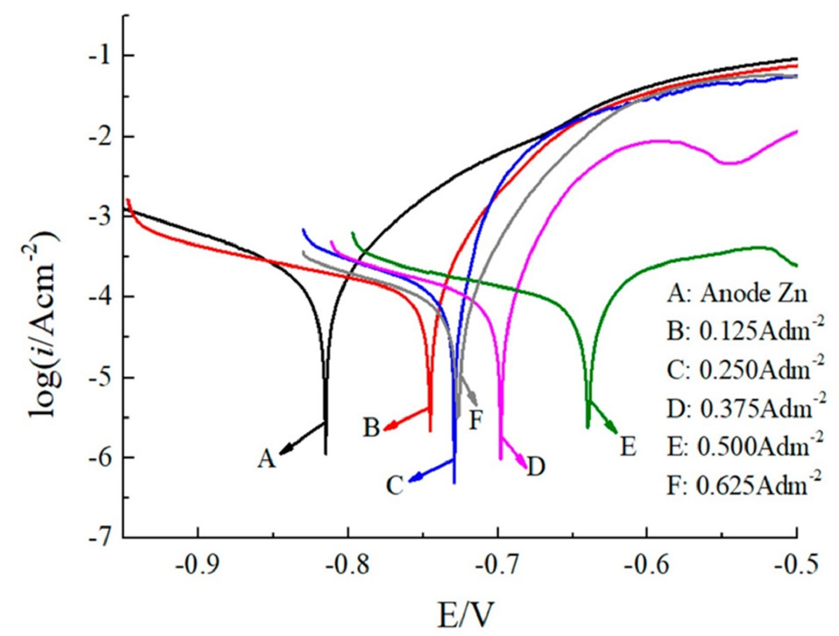
Figure 5. Tafel curves of deposited Zn coating at varying current densities [102].